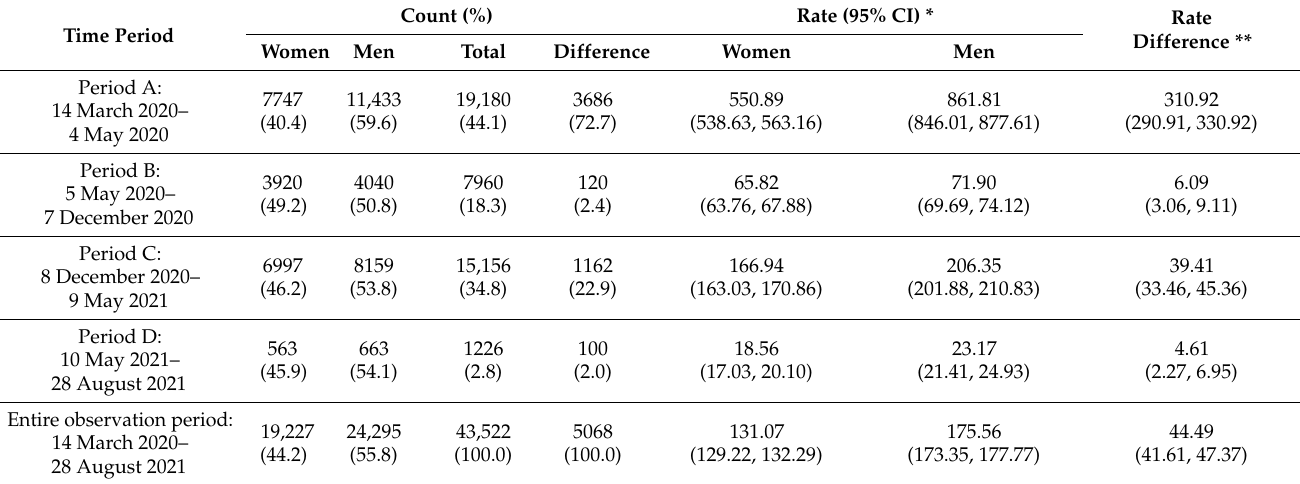
Table 1. COVID-19 mortality counts, rates and rate differences in New York State by time period, disaggregated by sex.